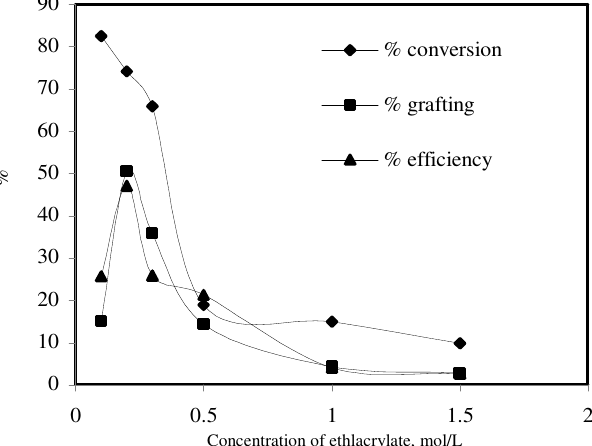
Figure 3. Influence of concentration of the ethyl acrylate on the grafting of bleached